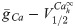
Assessing the dependence of fres and QZ on the linear g¯Ca−V1/2Cah∞ correlation.a. Parameter values for each model were changed along a line parallel (‖, blue) to the correlation line (black) or along a perpendicular line (┴, grey). This was done for models with high (cyan; a1), low (red; a2) and intermediate (grey; a3) g¯Ca models. For each model and each line, ‖ or ┴, we fit a line to the relative change in either fres or QZ as a function of the relative change in g¯Ca. b. The sensitivity values of fres or QZ to ‖ or ┴ are shown for the three groups.